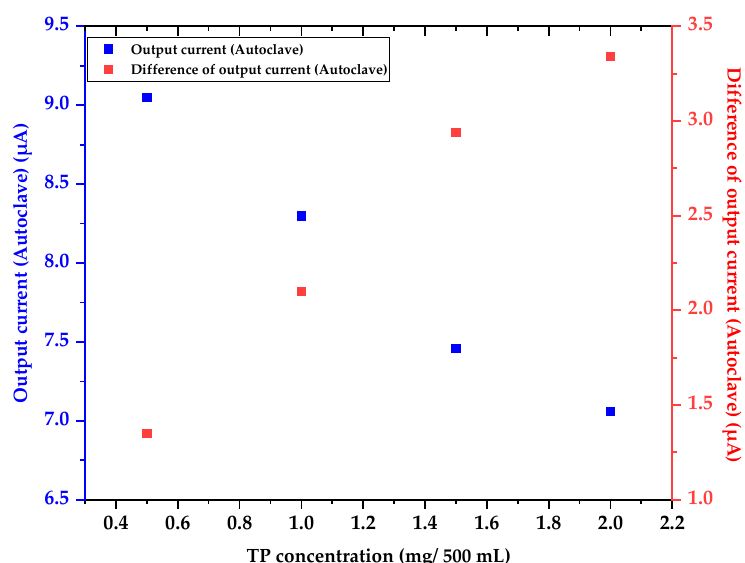
Figure 12. Graph of the output current and the difference of the output current as a function of the TP concentration (autoclave).